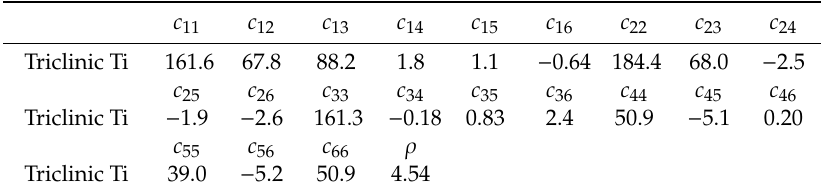
Table 1. The elastic constants c ij (in GPa) and the mass density ρ (g / cm 3 ) of a triclinic Ti crystallite reported in Ref.